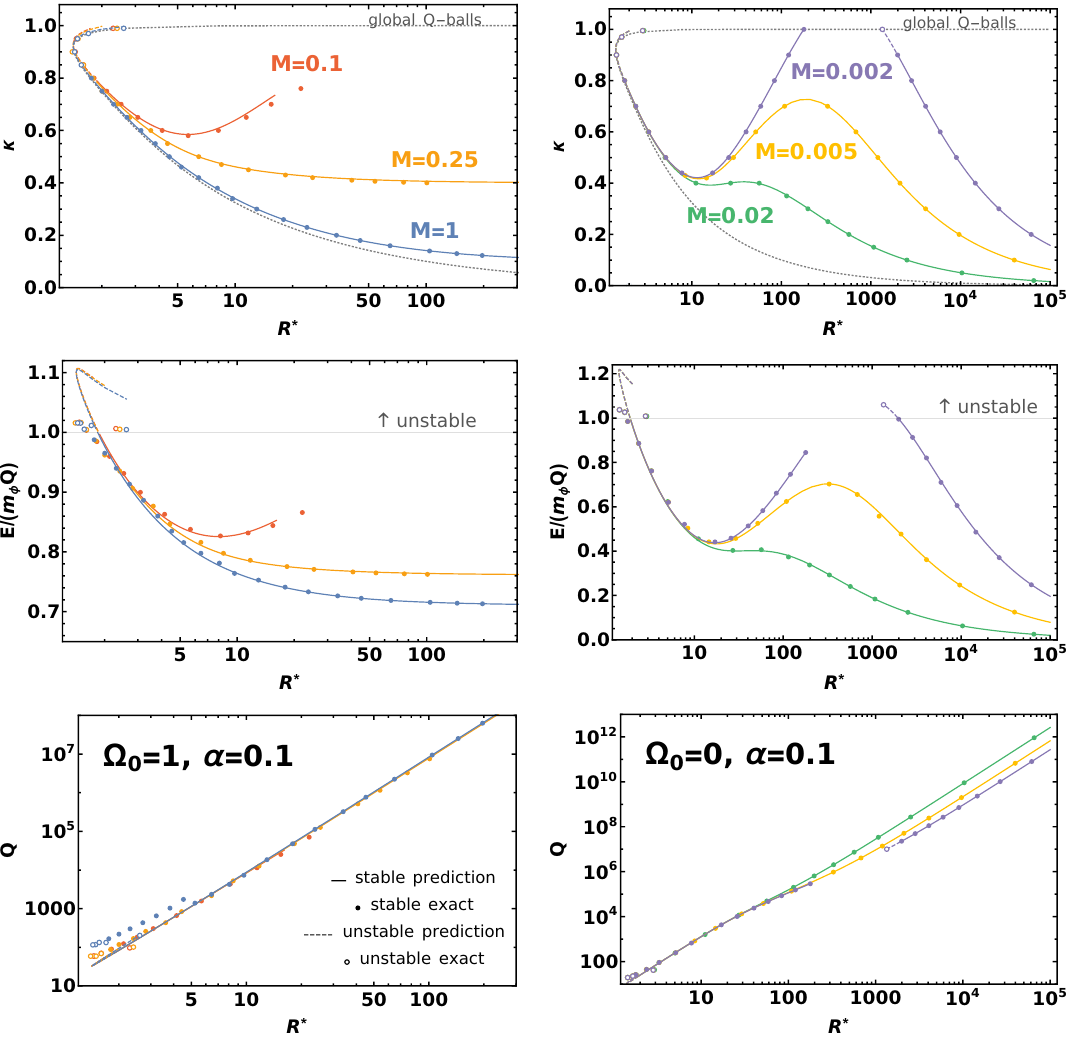
Figure 3 . Proca Q-ball solutions vs. R ∗ for Ω 0 = 1 (left column), Ω 0 = 0 (right column), and various M . Top row: κ ( R ∗ ) for Proca Q-balls. The solid lines correspond to our predictions using the mapping of eq. (3.6), the dots to exact numerical solutions, and the gray dotted line to the global Q-ball case shown for comparison. Middle row: E/ ( m φ Q ) vs. R ∗ using the same benchmark parameters as above. Q-balls are unstable for E/ ( m φ Q ) > 1 . Bottom row: Q vs. R ∗ . The solid lines are our analytic